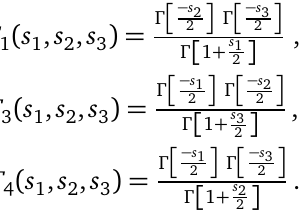
, F differ from their dispersive analogues G 4 5